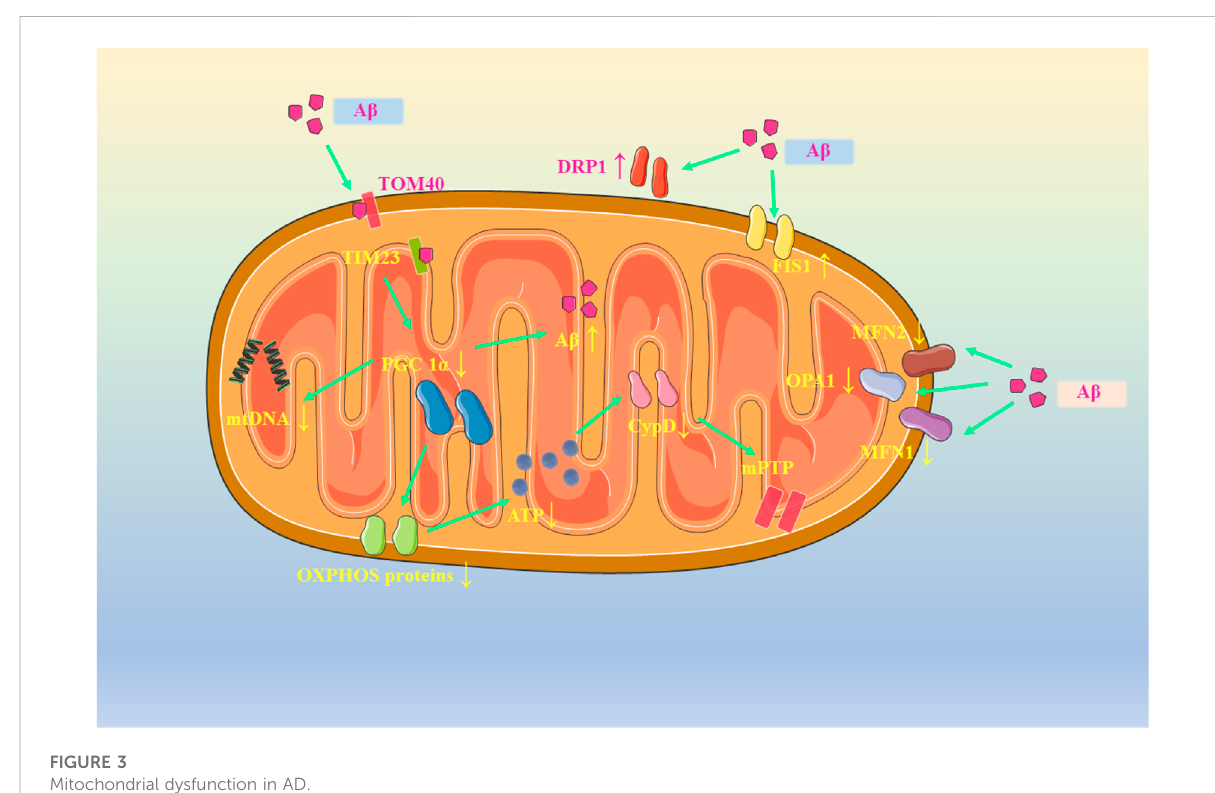
FIGURE 3 Mitochondrial dysfunction in